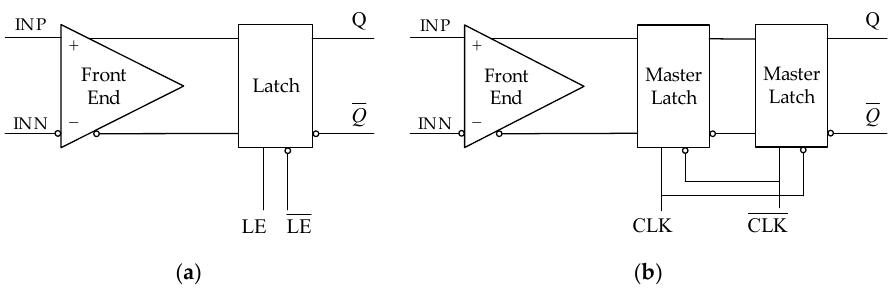
Figure 6. Comparator circuit topologies: ( a ) level-latched comparator; ( b ) edge-latched comparator (or clocked) .